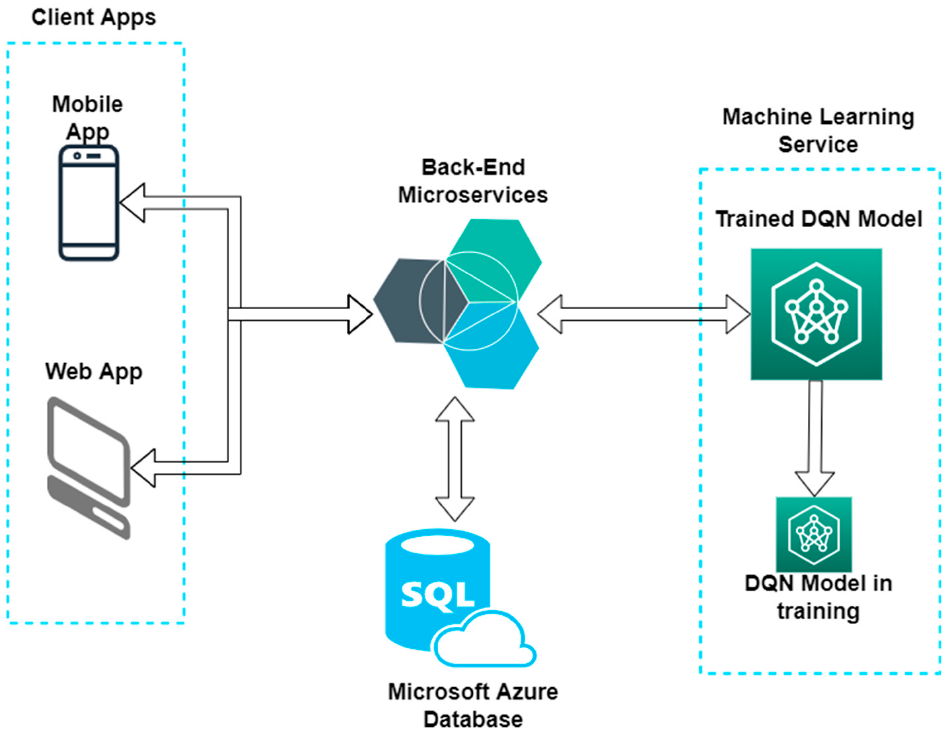
Figure 5. Architecture of the trained